Question: Identify the chart type used in this figure.
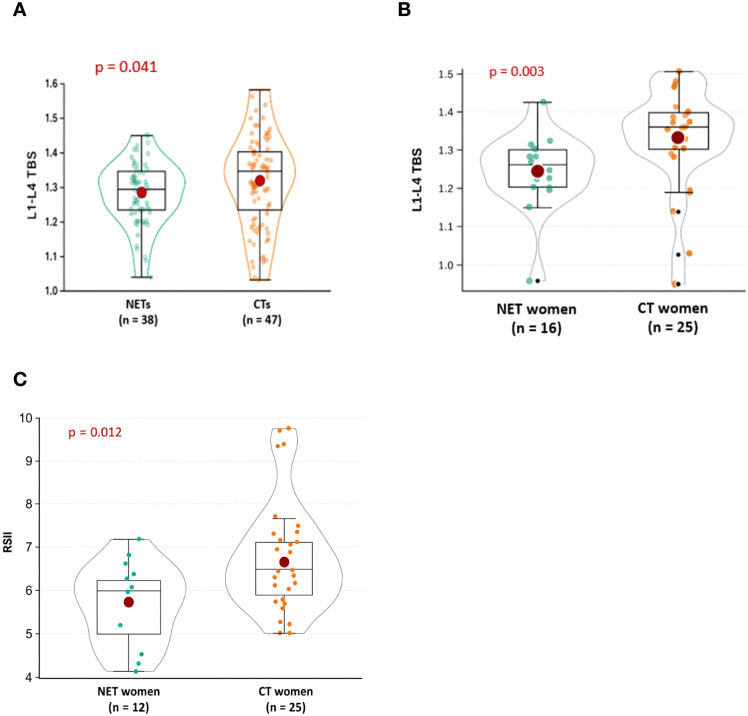
Answer: box